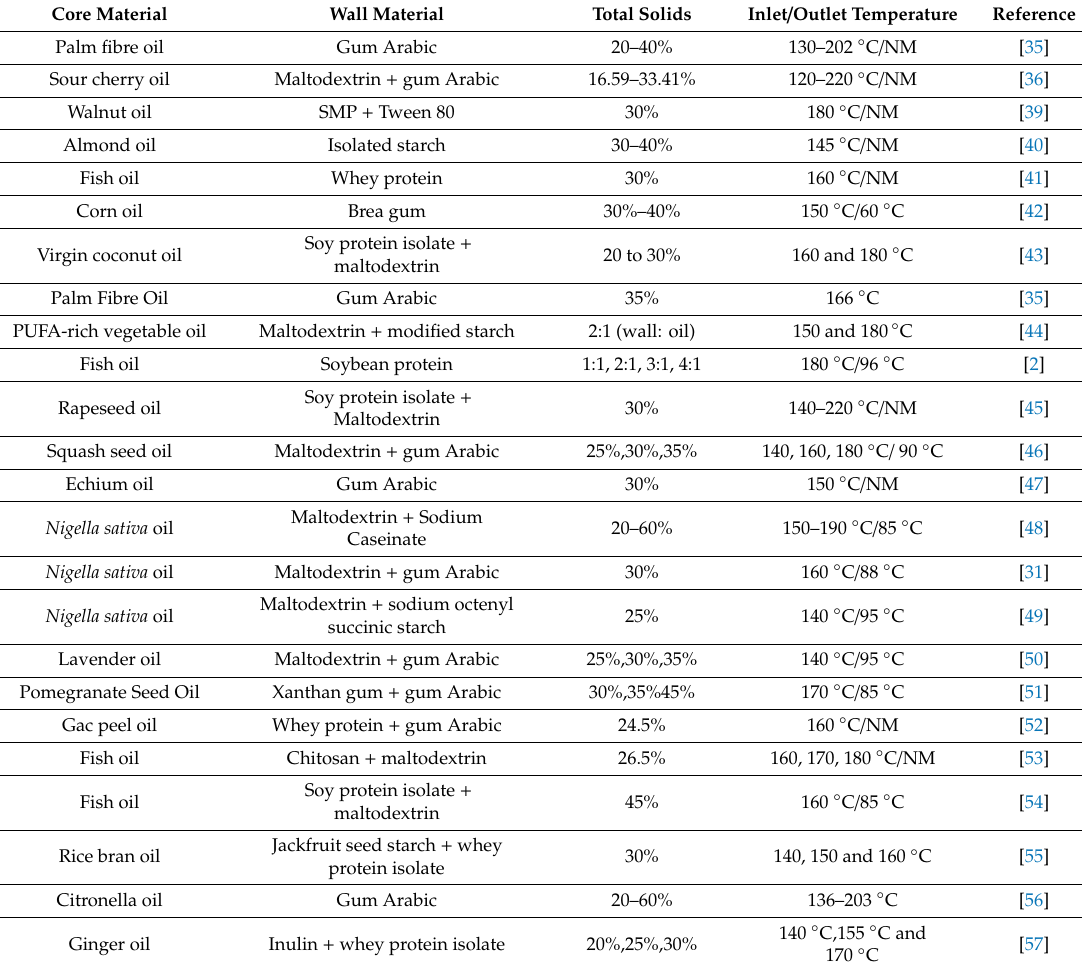
Table 1. Optimization of spray drying process conditions for various types of